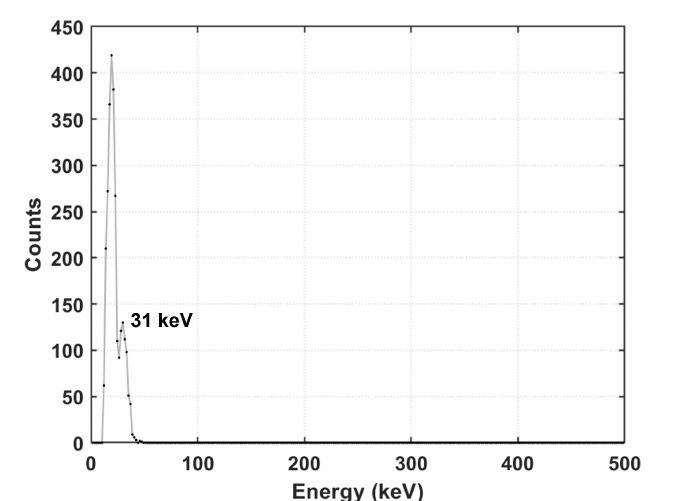
Figure 11. Spectrum resulting from a finer selection of events starting from the upper limit of the 31 keV N / I parameter distribution, contained in the first depth region ( N / I form 30 to 35).